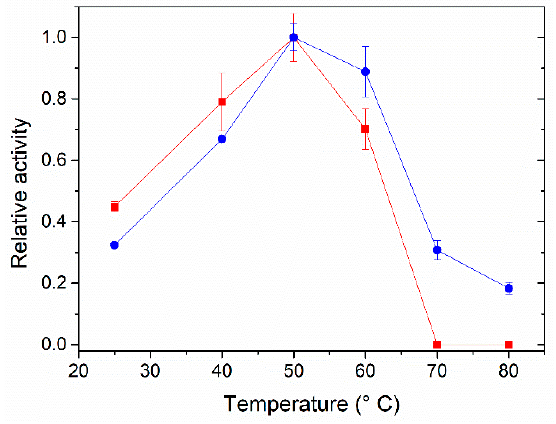
Figure 7. Profile of activity vs. temperature for ( ■ ) free and ( ● ) immobilized NPD (24 h immobilization time on agarose-glyoxyl). Activity assay conditions: hydrolysis of 0.36 mM N-benzoyl-L-tyrosine ethyl ester (BTEE) at different temperatures and pH 7.0 for 5 min.